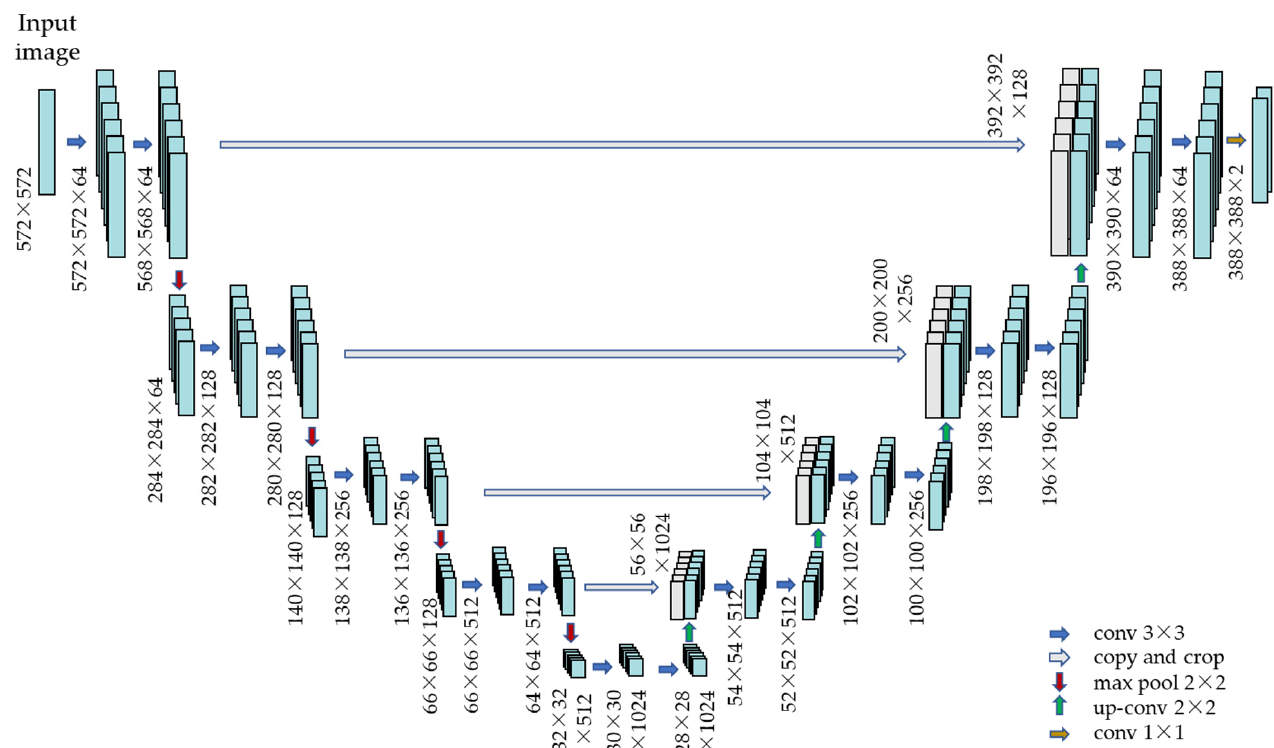
Figure 11. Road lane section processing during the segmentation step.